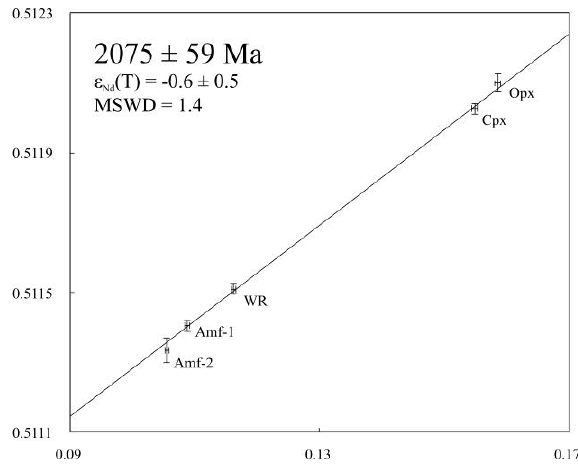
Figure 9. Sm–Nd mineral isochron for a hornblendite dyke (sample P-2).